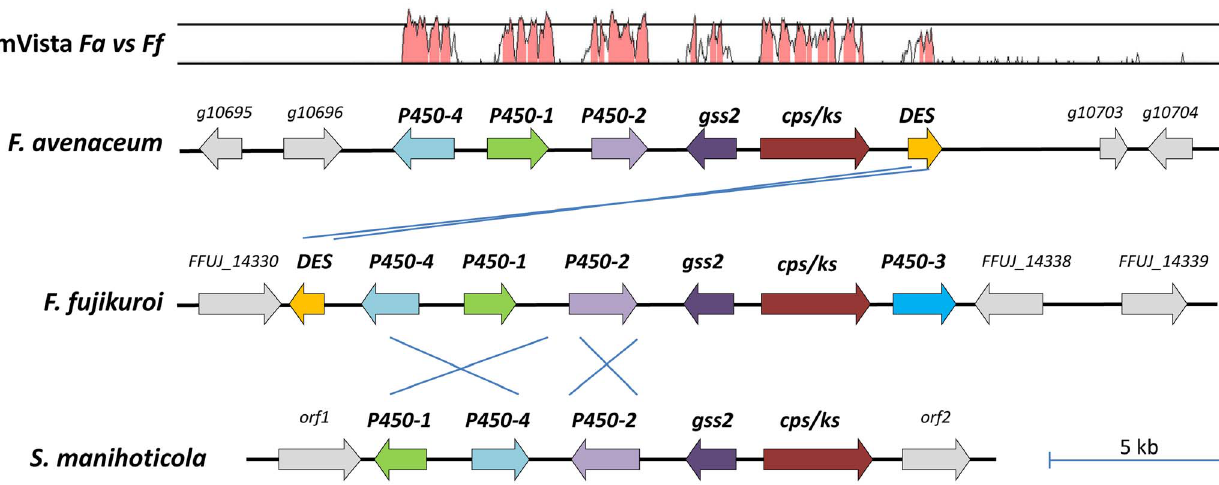
Figure 7. Architecture of the gibberellic acid (GA) gene clusters from F.fujikuroi MP-A, F.avenaceum and Sphacelomamanihoticola . The gene cluster and surrounding genes are identical in the three F. avenaceum strains and only Fa05001 is shown (FaLH03 cluster: FAVG2_04186 - FAVG2_04192 and FaLH27 cluster: FAVG3_04219 - FAVG3_04224 ). The mVista trace shows the similarity over a 100 bp sliding windows (Shuffle-LAGAN plot) between the F. avenaceum and F. fujikuroi clusters, bottom line =50% and second line =75% identity. Genes: gss2 = geranylgeranyldipho- sphate synthase, cps/ks = copalyldiphosphate/ent-kaurene synthase, P450-4 = ent- kaurene oxidase, P450-1 = GA 14 synthase, P450-2 = C20-oxidase, P450-3 = 13-hydroxylase and DES = desaturase. Note that the intergenic regions are unknown for the S. manihoticola GA cluster, while the size of these regions is not to drawn to size.